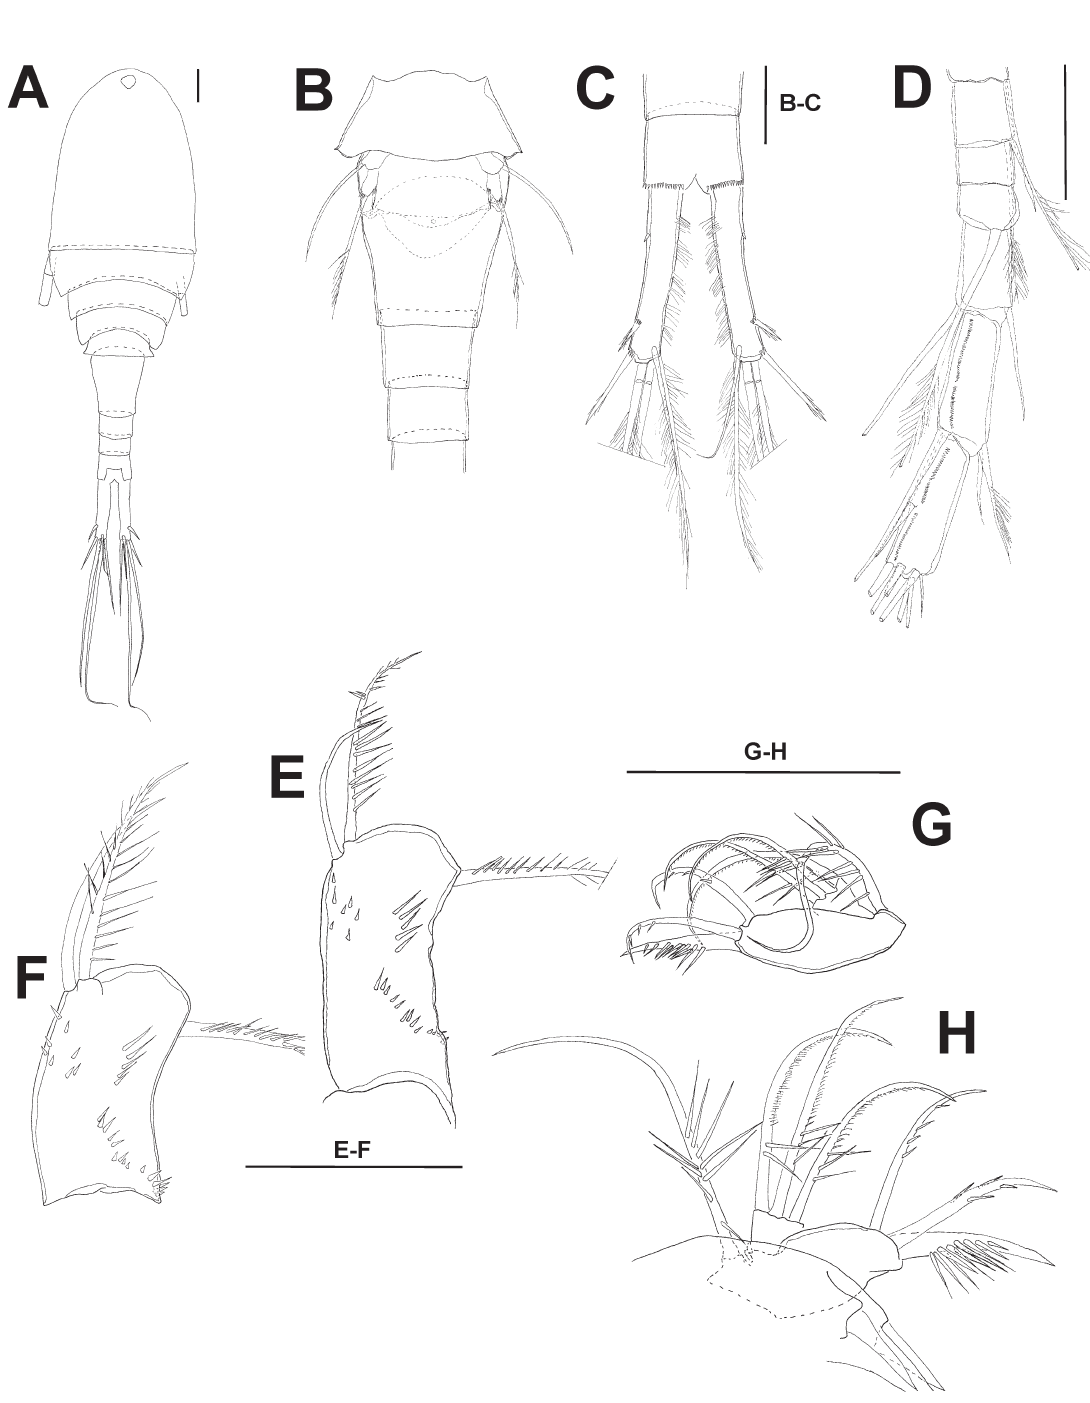
Fig. 7. Cyclops lacustris G.o. sars, 1863, ♀. A . Habitus, dorsal (smnk: 9567). B−C . Urosome, ventral (Lake aspern, norway − miZ 2/2016/20). B . Urosomites 1−4. C . anal somite and caudal rami. D . antennular segments 12−17, ventral (Lake aspern, norway − miZ 2/2016/20). E−F . antennal coxobasis, caudal. E . ♀ from Lake mjøsa, norway (Zmo: sars coll. 12977 ♀-2). F . ♀ from Lake aspern, norway (miZ 2/2016/20). G−H . maxillulary palp. G . ♀ from Lake mjøsa, norway (Zmo: sars coll. 12977 ♀-2). H . ♀ from Lake aspern, norway (miZ 2/2016/20). scale bars: a−H =